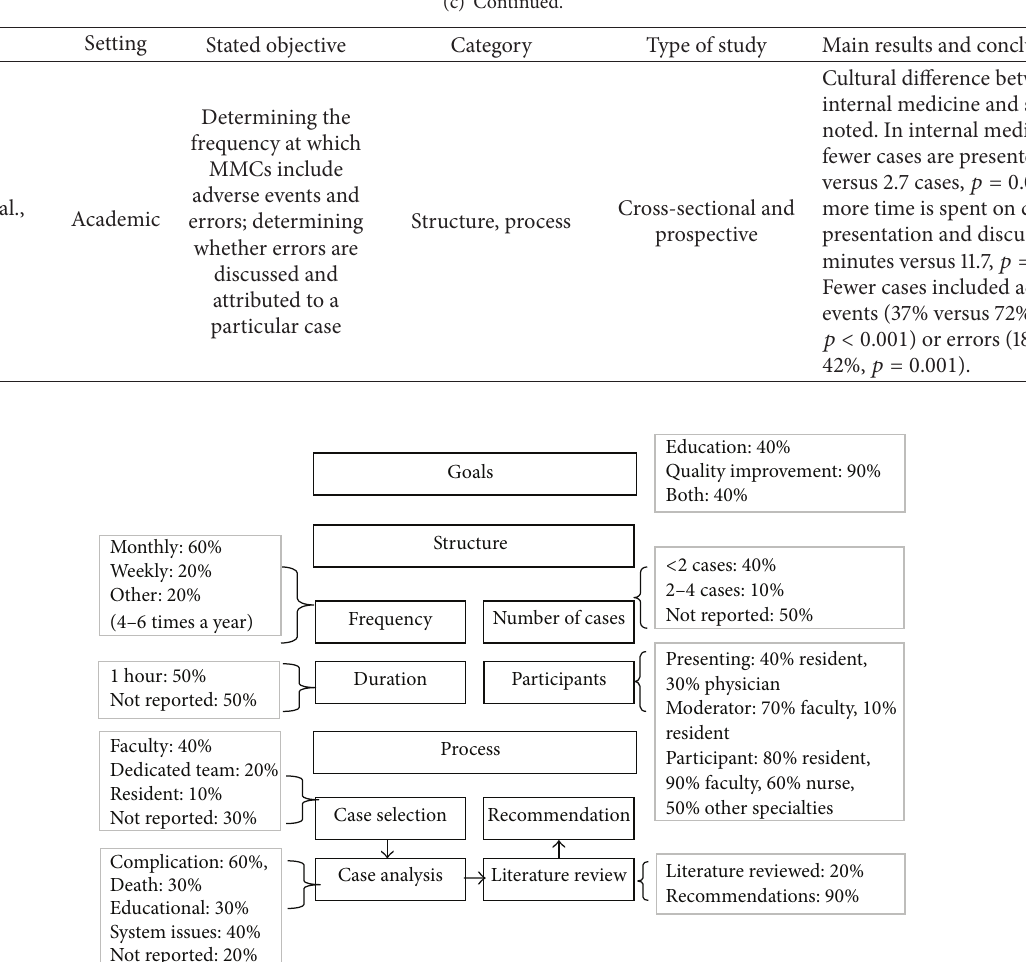
Figure 3: Characteristics of MMC in medicine ( 𝑛 = 10 , percentages not mutually exclusive).